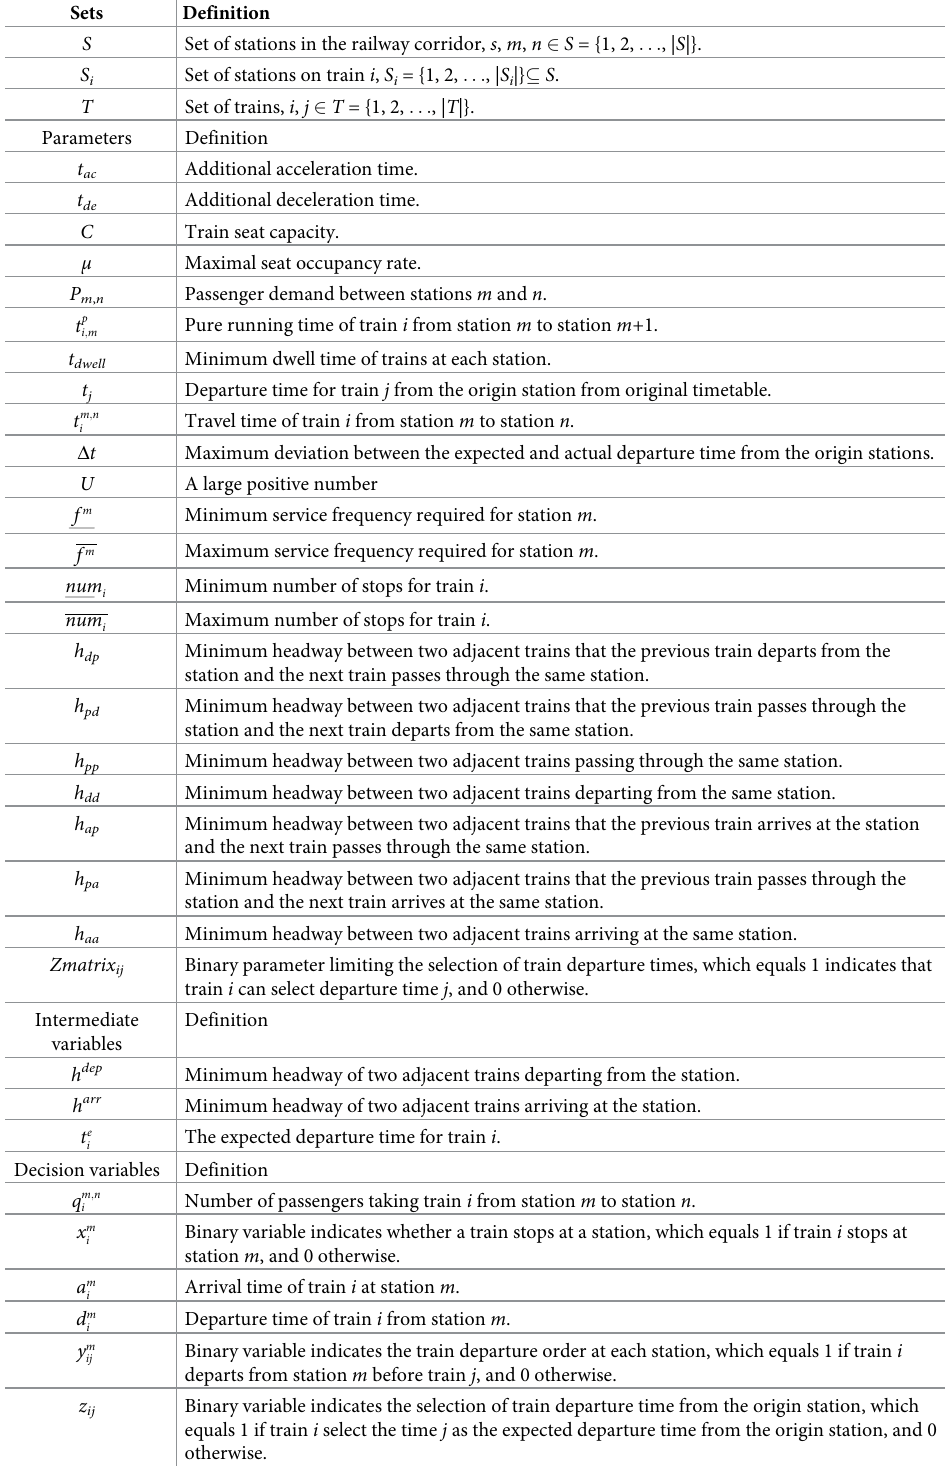
Table 2. Subscript, parameters and variables used in the